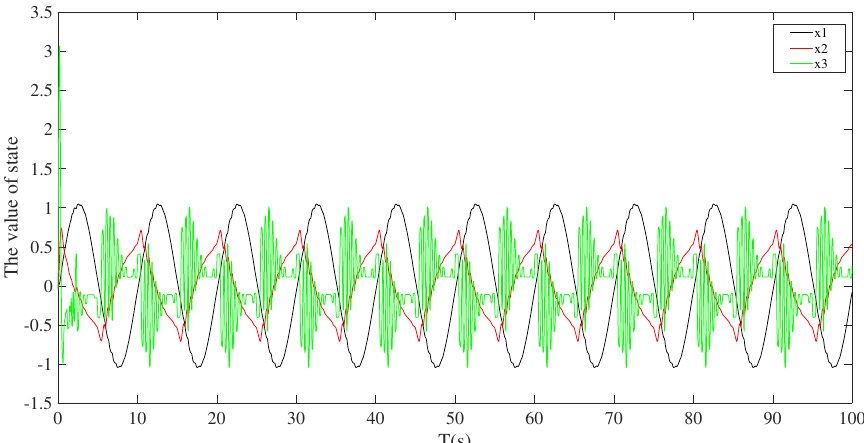
Figure 10. State curves in unknown time-varying delay form (with dead-zone compensation controller).